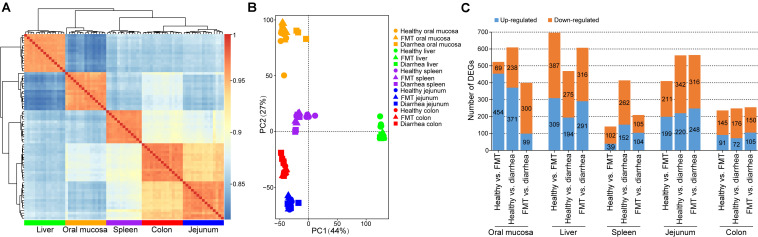
Variation and differential expression of genes in oral mucosa, liver, spleen, jejunum, and colon tissues. (A) Spearman’s r heatmap of gene expression between every pair of samples. (B) Principal component analysis (PCA) plot based on normalized gene expression levels (FPKM). (C) Distribution of up- and down-regulated DEGs across all tissues.